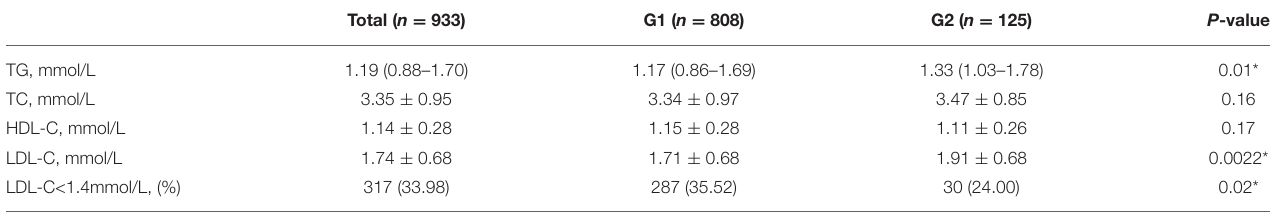
TABLE 3 | Comparison of the lipid profile at the follow-up period between the two